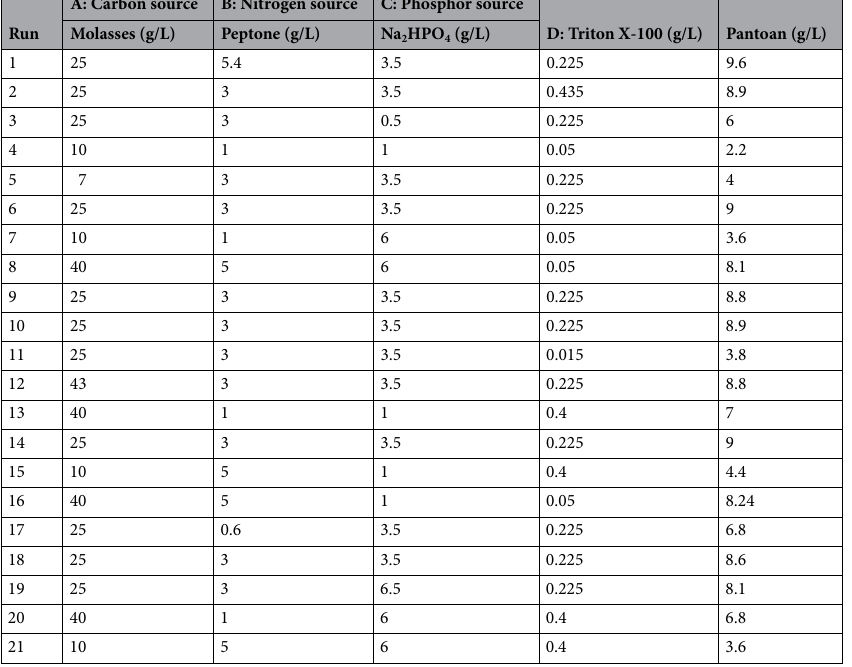
Table 4. A central composite design array with responses (in actual units) for Pantoan production after 48 h of fermentation.